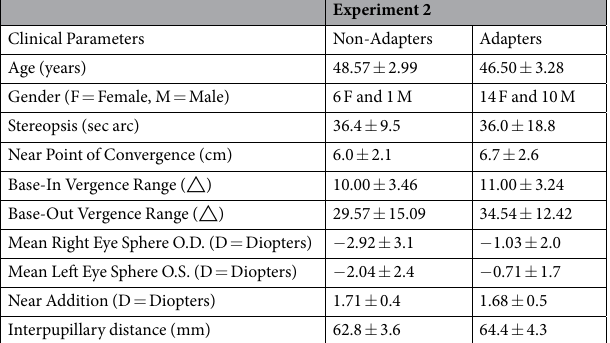
(PNAS, left column; PAS, right column). Group averages of 4° convergence peak velocities from baseline and modification phases are summarized in Fig. 3A. An unpaired t- test revealed statistical differences in 4° con- vergence peak velocities between groups during both baseline (T = 2.28, p = 0.04 ) and modification (T = 3.14, p < 0.01) phases. PNAS subjects exhibited slower 4° convergence responses during baseline and modification phases compared to PAS subjects. An unpaired t -test revealed statistically significant differences for the first high-velocity component (T = 2.86, p = 0.013) but showed no significant differences for the second high-velocity component (T = 0.02, p = 0.98) (Fig. 3B). For the first high-velocity component, PNAS subjects exhibited slower high-velocity components when compared to the PAS subjects. Figure 4A demonstrates a significantly greater change in 4° convergence peak velocity among PAS subjects as compared to PNAS subjects (T = 3.66, p = 0.002). The high-velocity ratio was quantified as the first high-velocity component divided by the second high-velocity component. The high-velocity ratios between PNAS and PAS were also significantly different (T = 2.43, p = 0.030) as shown in Fig. 4B, where the ratio was greater in PAS compared to PNAS.